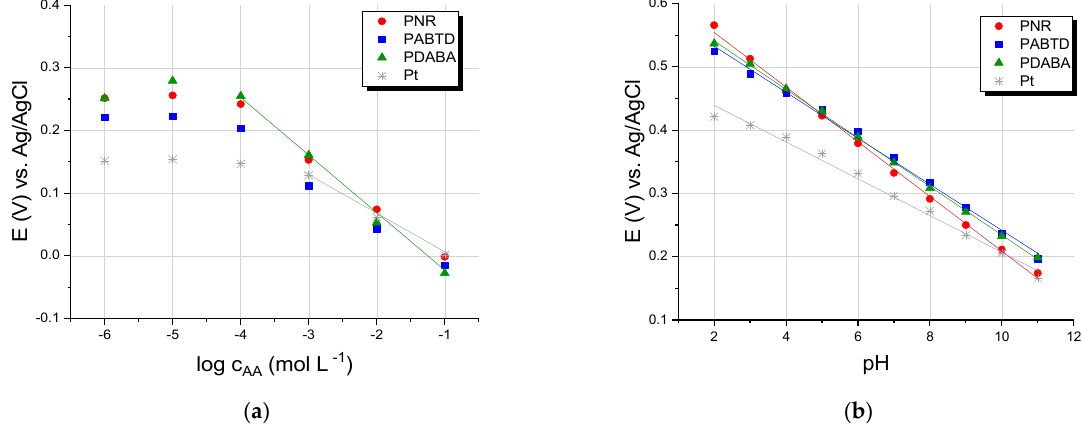
Figure 2. Dependences of electromotive voltage of individual types of electrodes ( a ) on the logarithm of the concentration of ascorbic acid (AA) dissolved in acetate buffer at pH 5, and ( b ) on the pH in Britton–Robinson buffer of pH range 2–11.